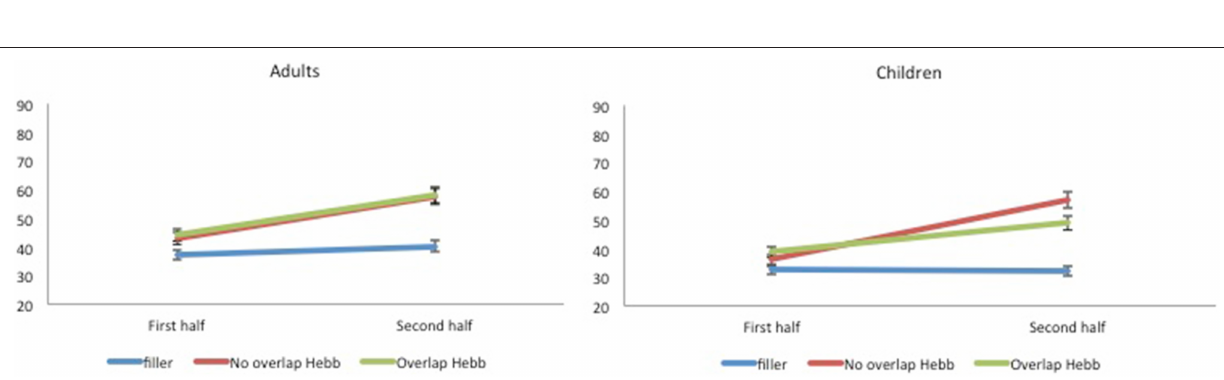
Frontiers in Psychology |